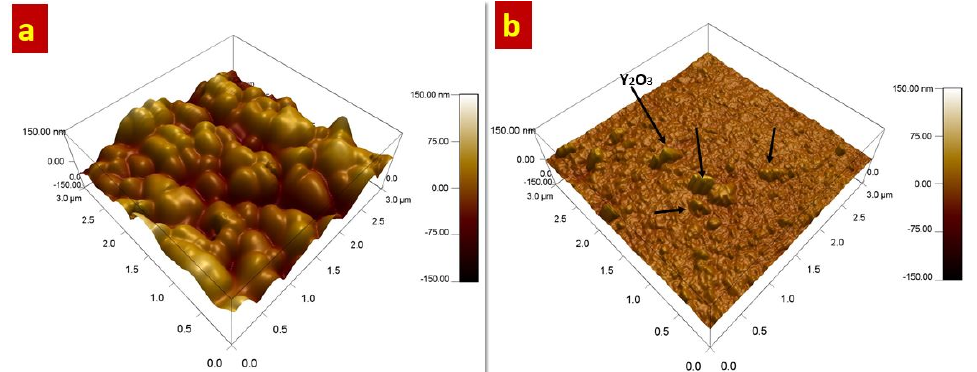
Figure 4. Coating morphology; AFM images of electrodeposited Ni ‐ B ( a ) and Ni ‐ B ‐ Y 2 O 3 composite coatings with arrowheads indicating incorporated Y 2 O 3 particles ( b ).